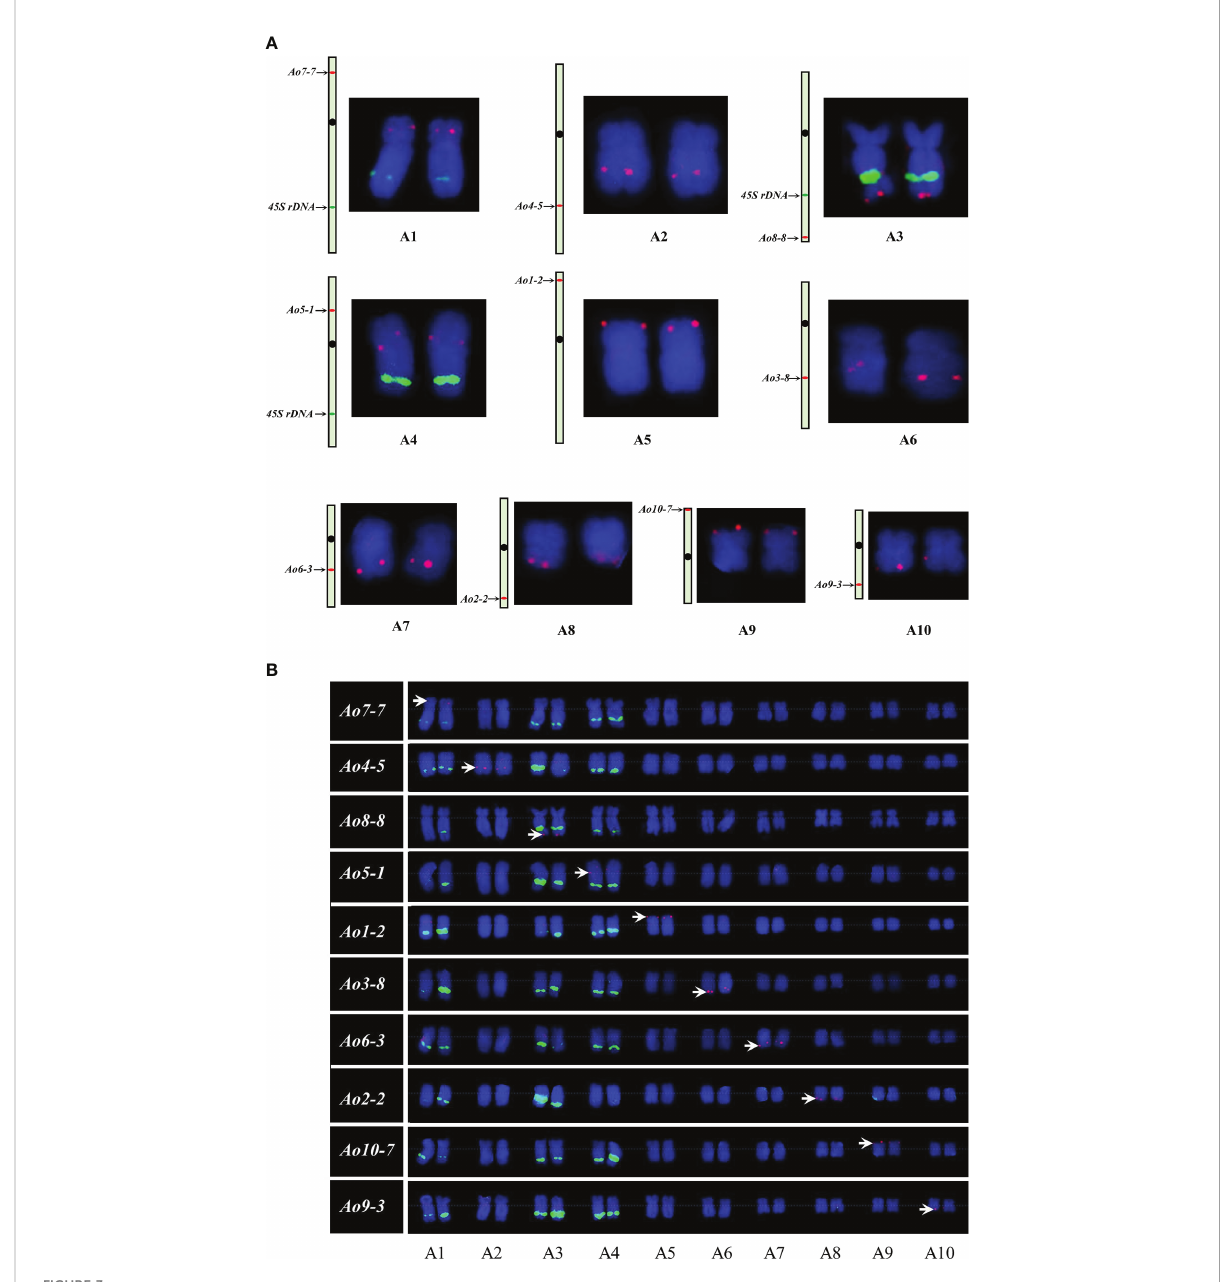
FIGURE 3 Single copy gene-based FISH analysis on somatic chromosomes in garden asparagus. (A) Sequence mapping of chromosome-speci fi c FISH probes and their FISH signals on individual chromosomes. (B) Karyotypic analysis of garden asparagus chromosome based on chromosome- speci fi c markers. The arrows denote the chromosome-speci fi c FISH signal (red). The green signal represents the signals of 45S